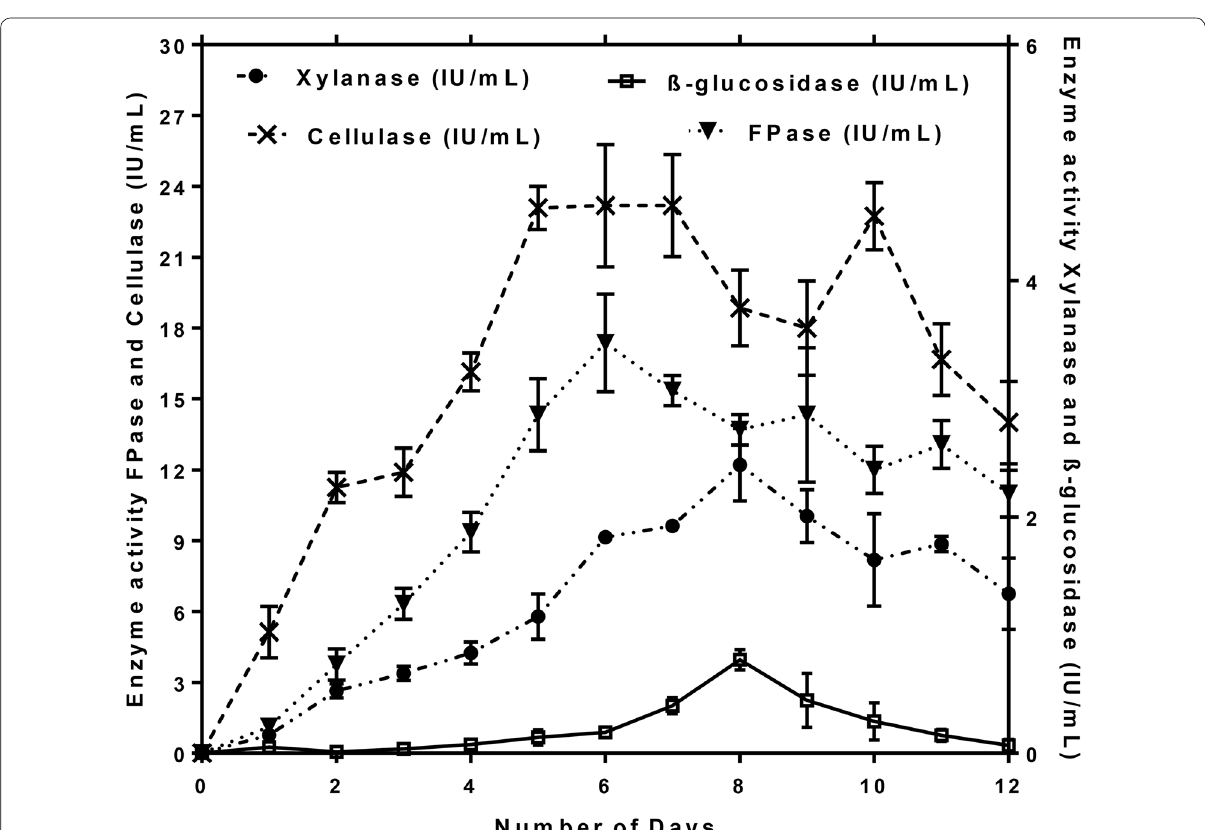
Fig. 6 Profiles of cellulases and xylanase produced by Aspergillus fumigatus JCM 10253 in SSF using wheat bran as a